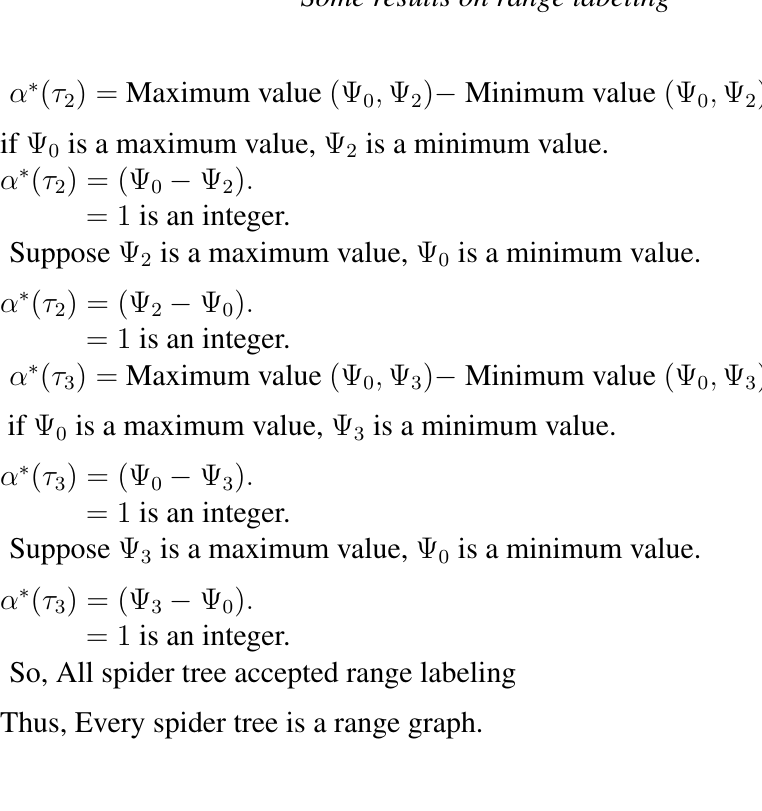
Fig.2. Range Labelling for Spider Tree.